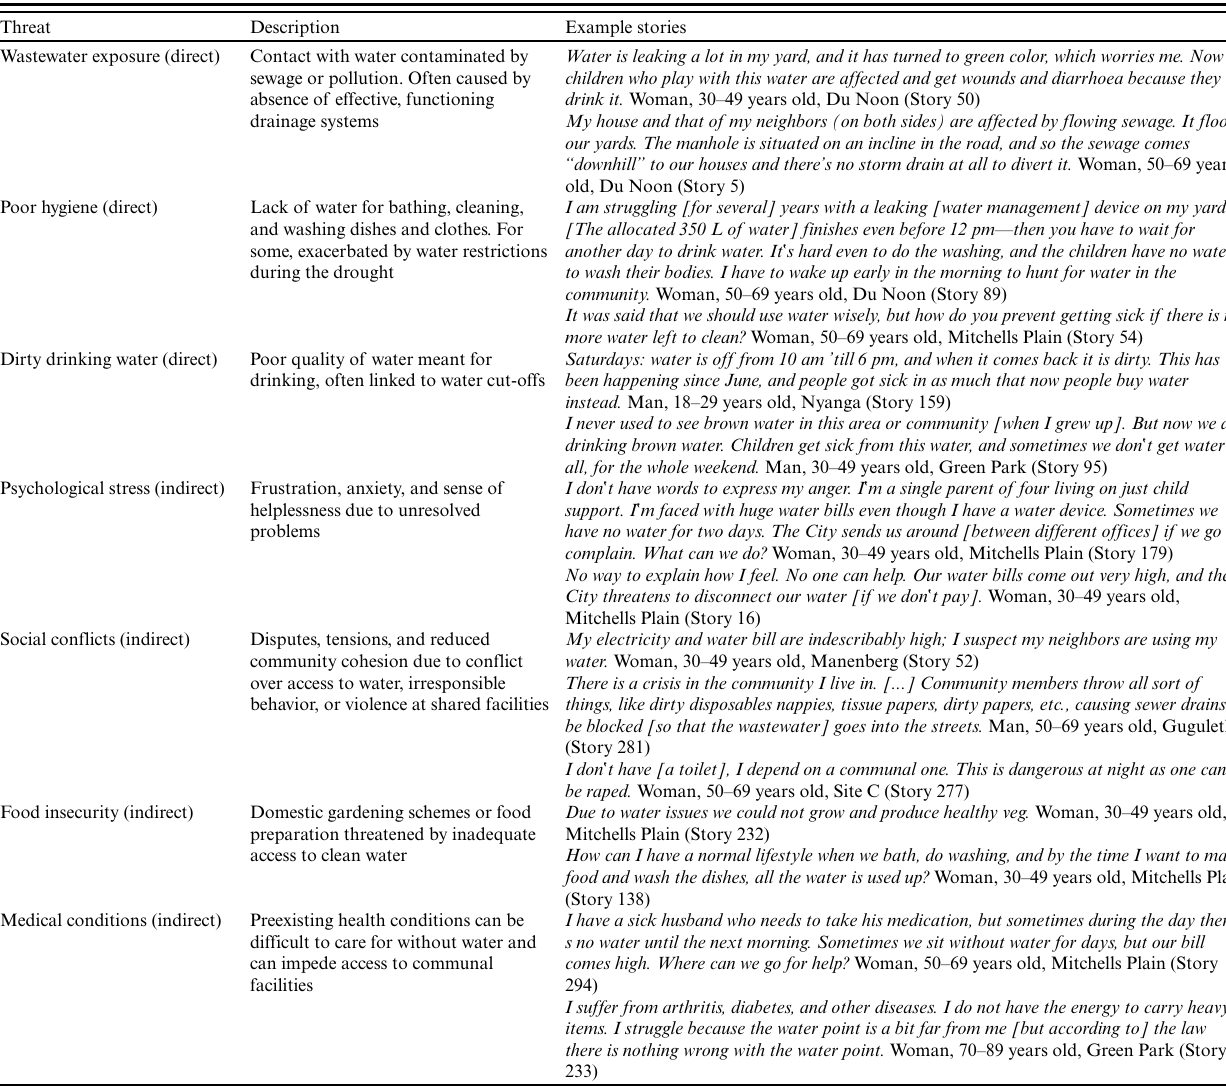
Table 1. Overview of the direct and indirect water-related threats to well-being, with example stories to relay respondents’ perspectives directly. Story numbers from the original study are included for